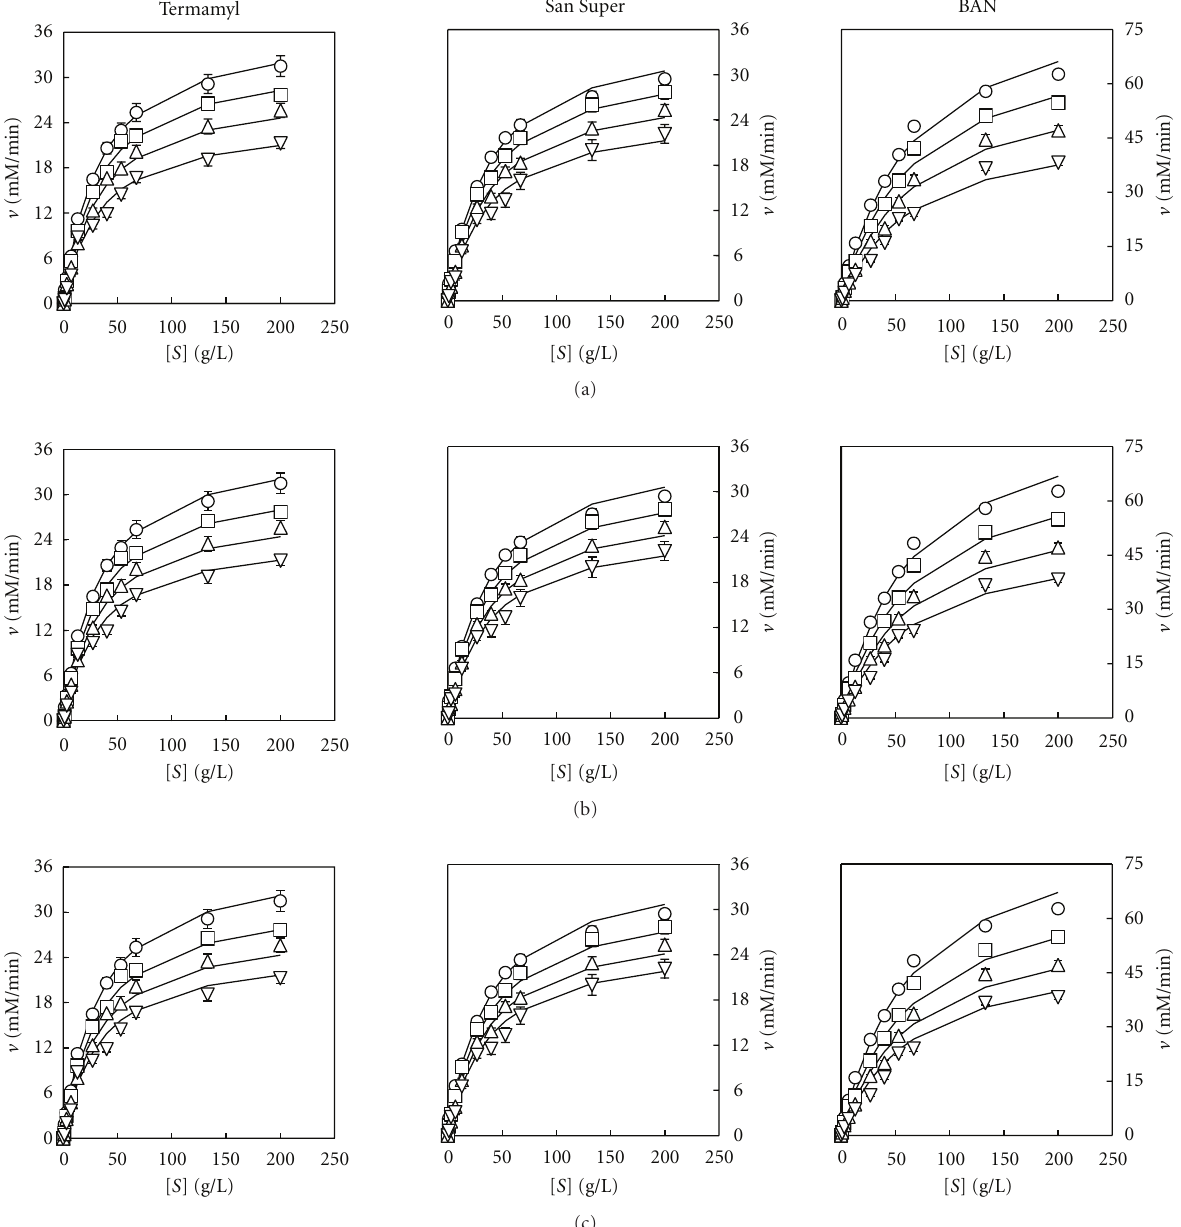
Figure 6: Changes in velocity ( v ) for each amylolytic enzyme with the concentration of starch (O) and starches [ S ] mixed with initial gelatine concentrations [ G ] of 25 g/L ( (cid:2) ), 50g/L ( (cid:3) ), and 75 g/L ( ∇ ). The experimental points (as means ± standard deviations) are the amylolytic activity data showed in Figure 5(a) for each enzyme. The curves drawn through the experimental velocity data in (a), (b), and (c) were obtained according to the models (5), (6), and (7),